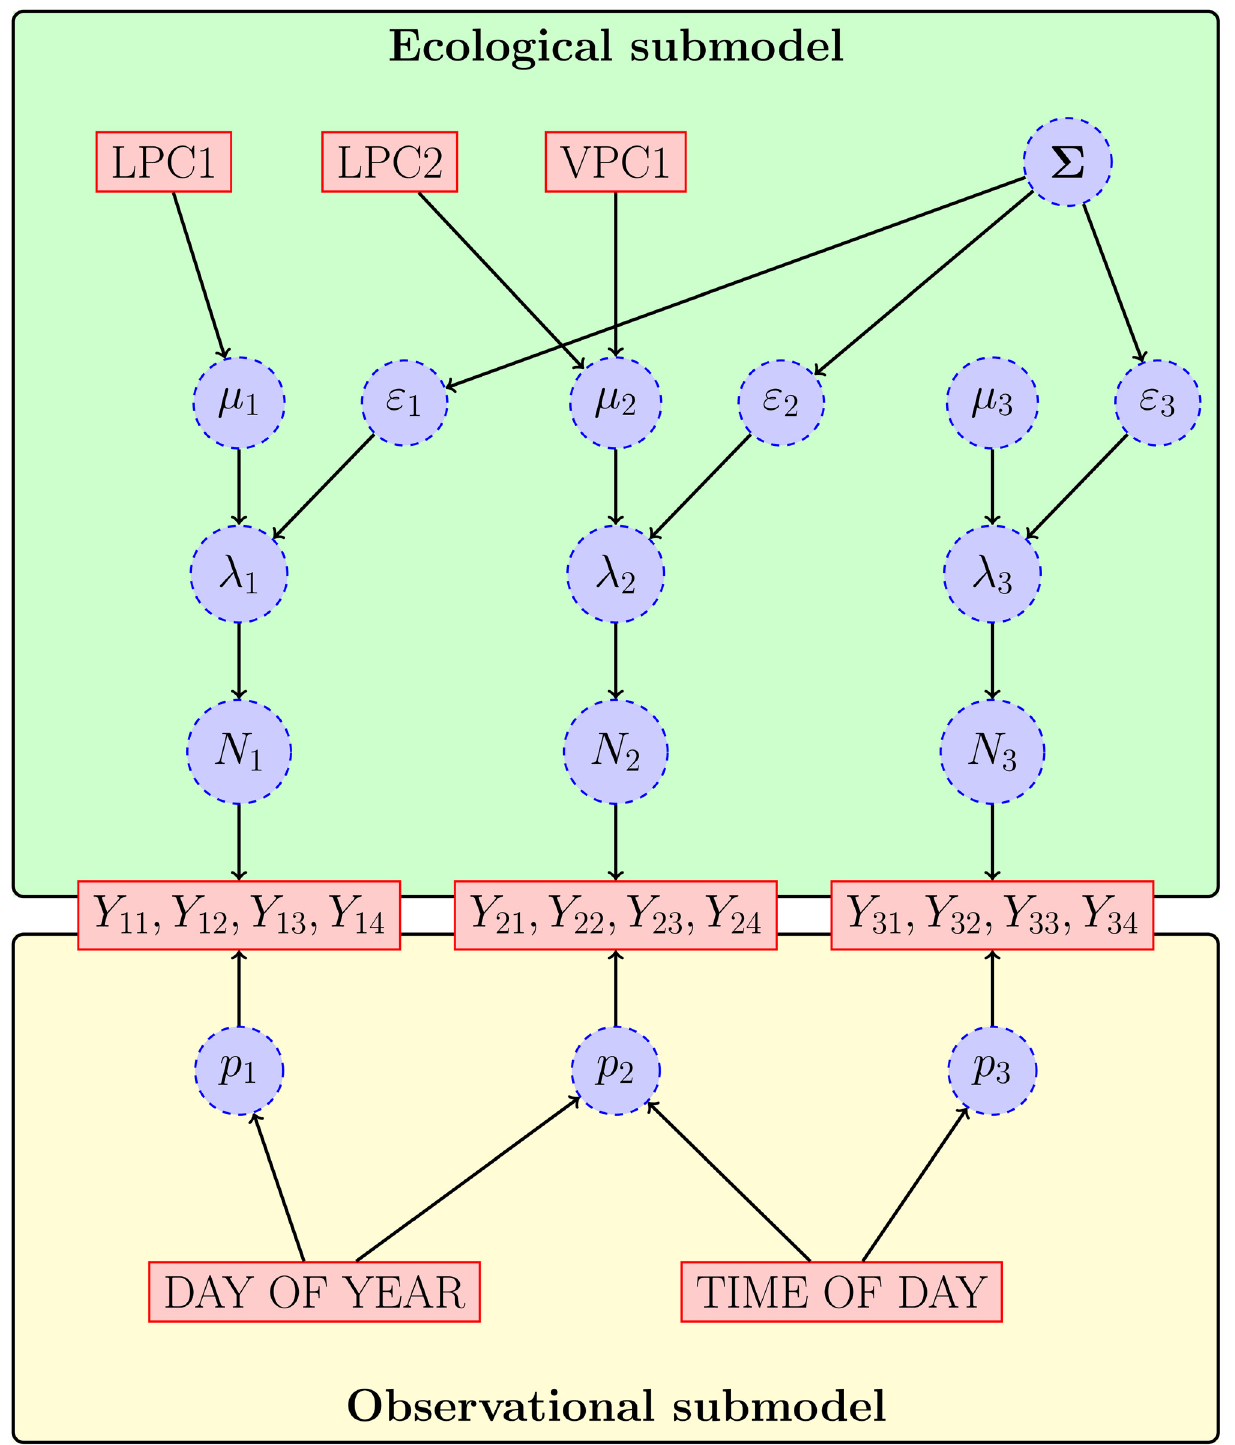
Fig 1. Schematic representation of the N-mixture model of correlated abundances for 3 species. Solid rectangles correspond to observed quantities (covariates or individual capture histories). Dashed circles correspond to latent random variables. Notation is described in Multispecies N-mixture model of correlated abundances. Covariates of abundance (LPC1, LPC2, VPC1) and detection probability (DAY OF YEAR, TIME OF DAY) are described in Statistical analysis of avian data.